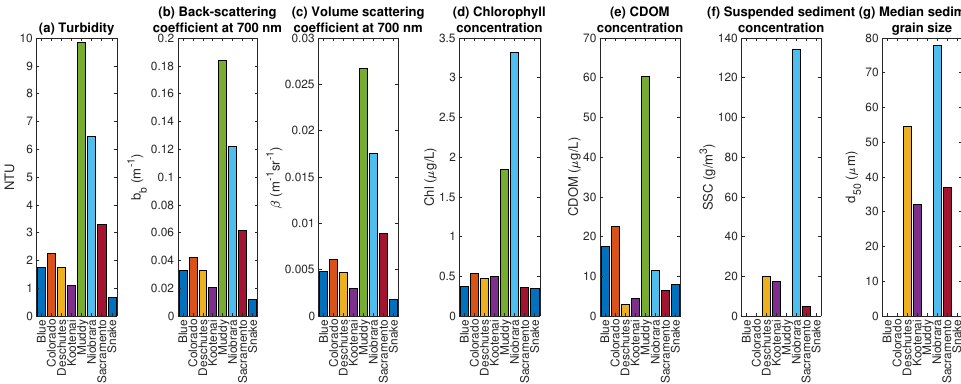
Figure 4. Water column characteristics measured on the Kootenai River along with similar data from seven other rivers throughout the western USA for comparison. Note that suspended sediment data was not available for the Blue, Colorado, and Snake Rivers, nor for Muddy